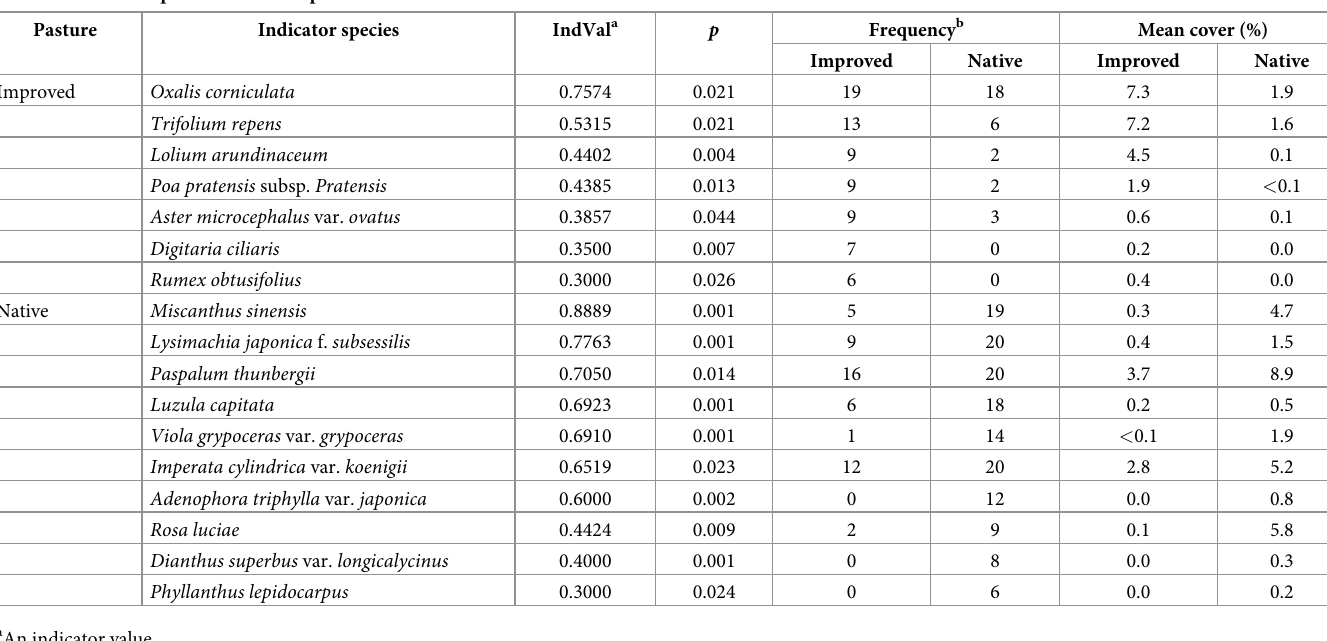
Table 1. Indicator species for the two pastures in